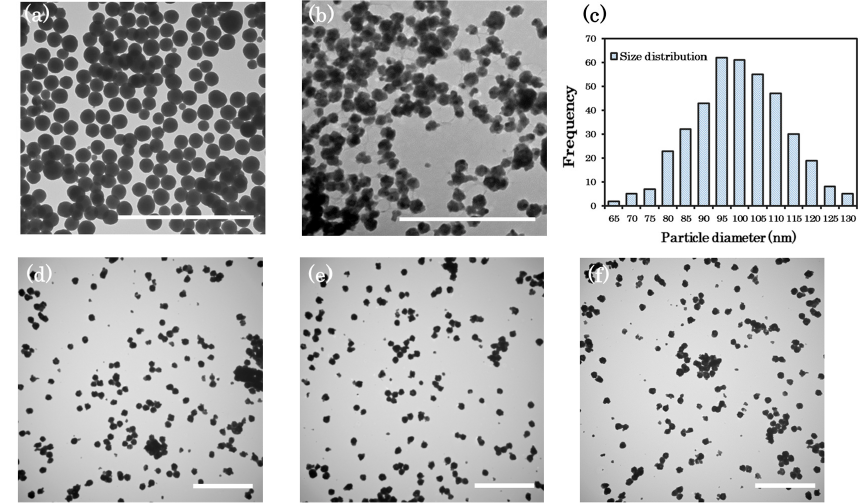
Figure 2. ( a ) and ( b ) show the TEM images of Gd 2 O 3 co ‐ doped Ln 3+ /Yb 3+ nanoparticles generally produced from the HP method before and after calcination, respectively. The size distribution of nanoparticles pre ‐ calcination synthesized from the HP method is shown in ( c ); The calcined nanoparticles of Gd 2 O 3 co ‐ doped ( d ) Tm 0.1 mol %/Yb 2 mol %; ( e ) Ho 1 mol %/Yb 2 mol %; and ( f ) nanoparticles of Gd 2 O 3 co-doped ( d ) Tm 0.1 mol %/Yb 2 mol %; ( e ) Ho 1 mol %/Yb 2 mol